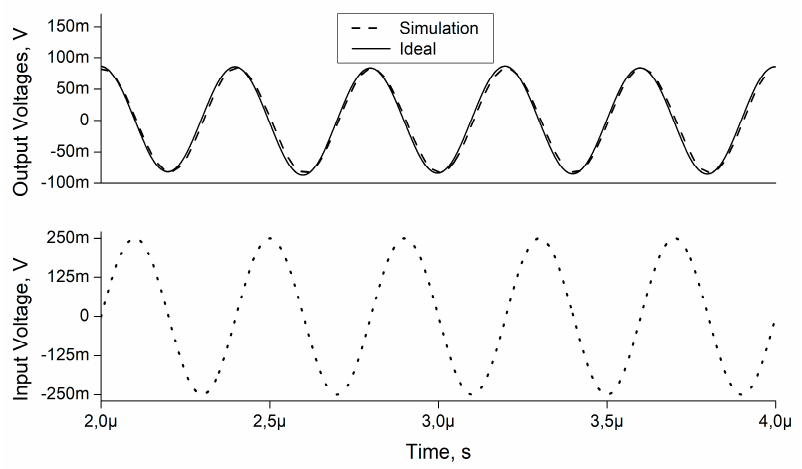
Figure 11. Time-domain analysis for the HP ladder filter example.